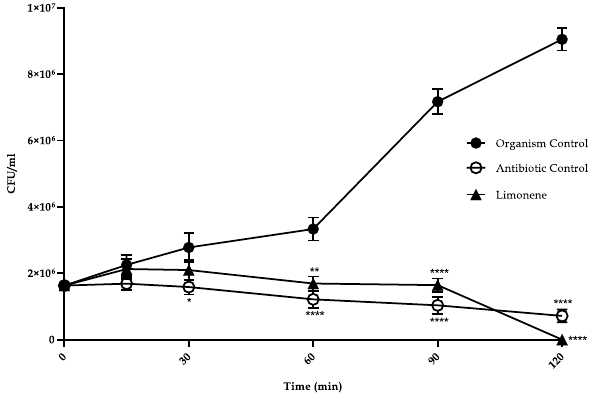
Figure 3. Time Kill Curve of limonene (1XMIC) against Escherichia